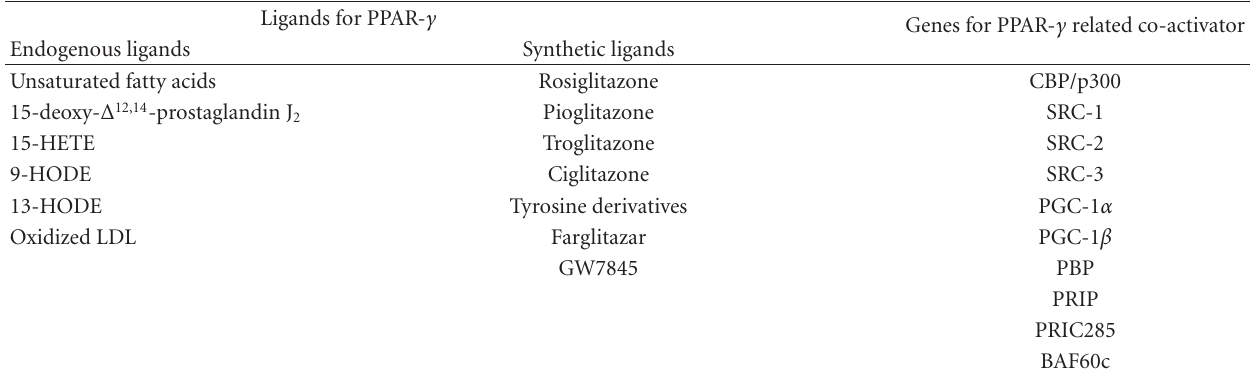
Table 1: Endogenous and synthetic ligands for PPAR- γ and genes for PPAR- γ related